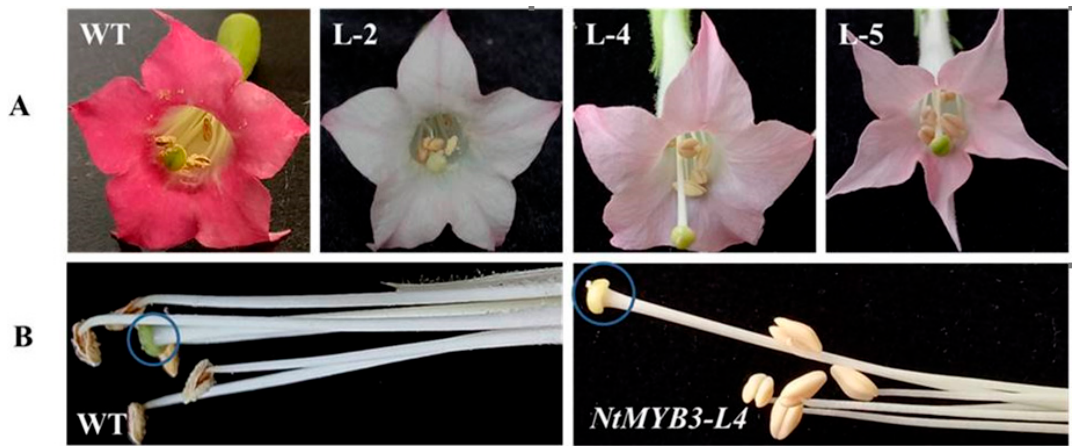
Figure 4. Floral phenotypes of transgenic tobacco plants carrying NtMYB3 gene.Wild type tobacco (WT) and transgenic lines of tobacco are (L-2, L-4 and L-5). Flower color comparison in wild type (WT) and transgenic lines ( A ); Comparison of pistil length in WT and transgenic tobacco ( B ). Blue circle indicated the top of the pistal length.